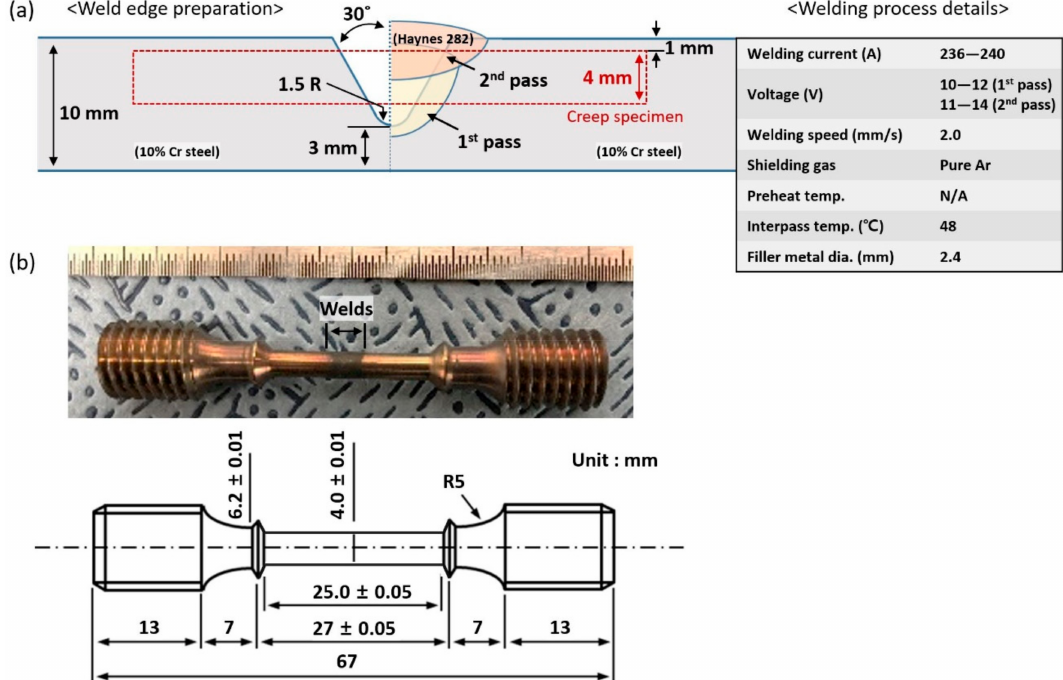
Figure 1. ( a ) Schematic diagram of weld-edge preparation and welding conditions; ( b ) shape and dimensions of creep test